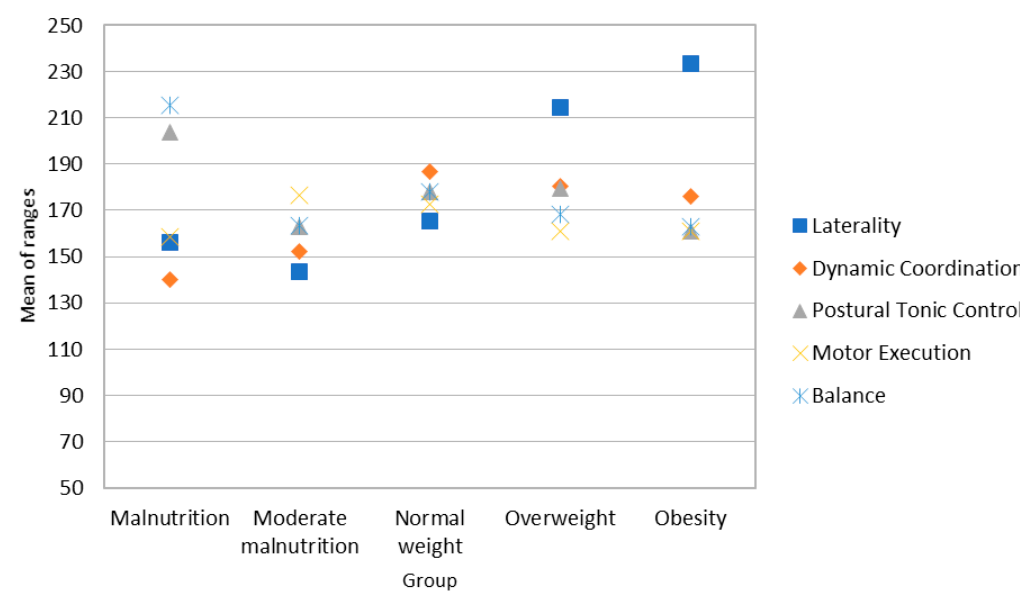
Figure 2. Average range of the scores for motor skills in the sample of boys.